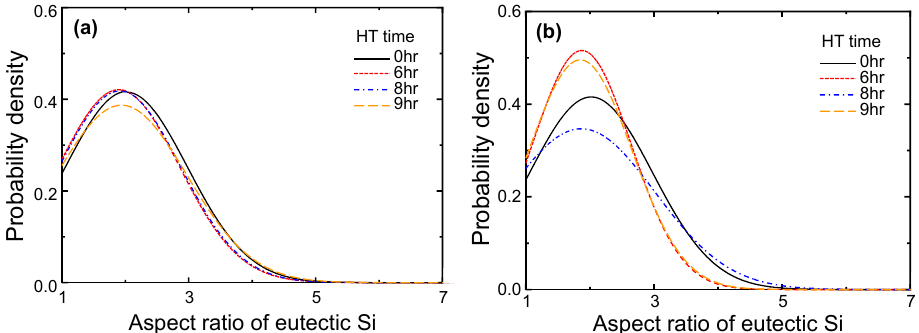
Figure 10. The standard nominal distribution of the eutectic Si aspect ratio at different heat treatment temperatures: ( a ) 160 ◦ C and ( b ) 200 ◦